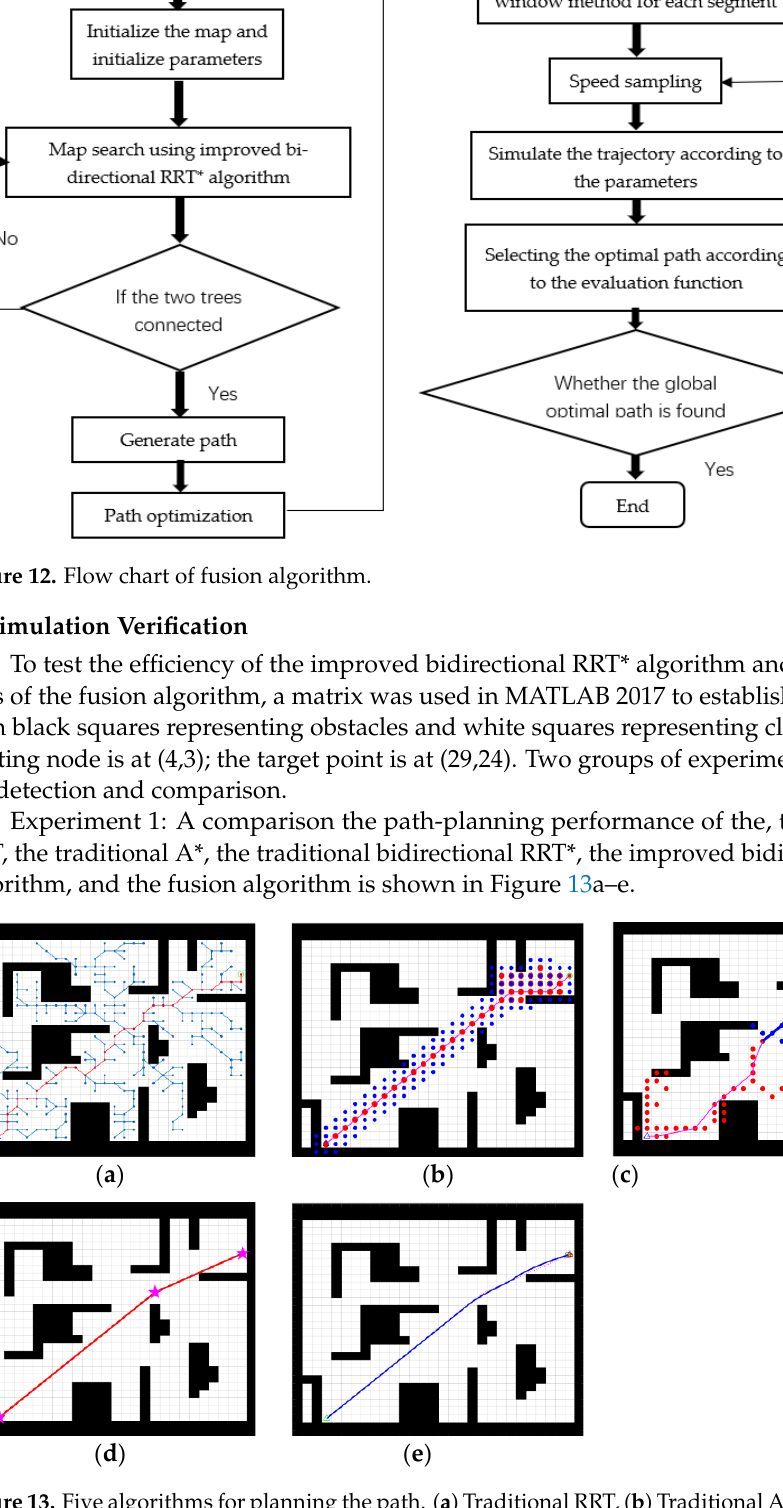
Figure 11. Diagram of fusion algorithm.